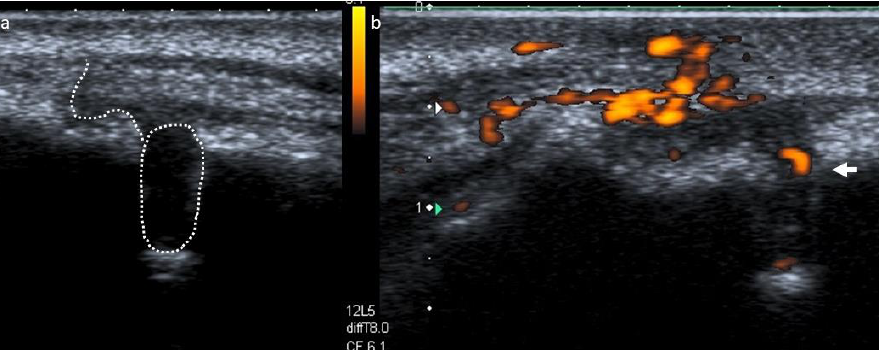
Figure 3. ( a ) B-mode ultrasound examination showing a sinus tract disrupting the vestibular bone, presenting as a dishomogeneous, hypoechoic pathway lined by echogenic and reinforced contours. ( b ) Power Doppler applied to the same area, showing an echogenic, solid lesion with poorly defined hyperechoic bone boundaries and internal blood vessels.